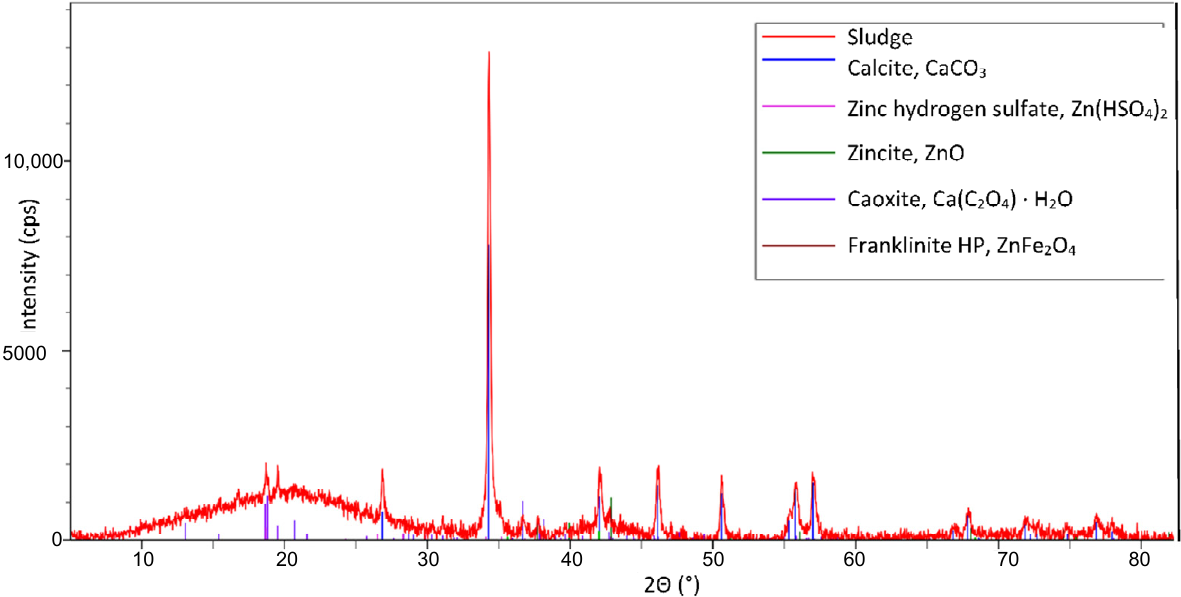
Figure 3. X-ray diffraction analysis for a presence of phases in the sludge sample from P20 supplier. Leaching solutions were prepared from concentrated acids by dilution. The initial concentration of acids was 93% for sulfuric acid, 65% for nitric acid and 35% for hydro- acid solution to 18% or 20%, the nitric acid solution to 12% and the hydrochloric acid solution to 7% or